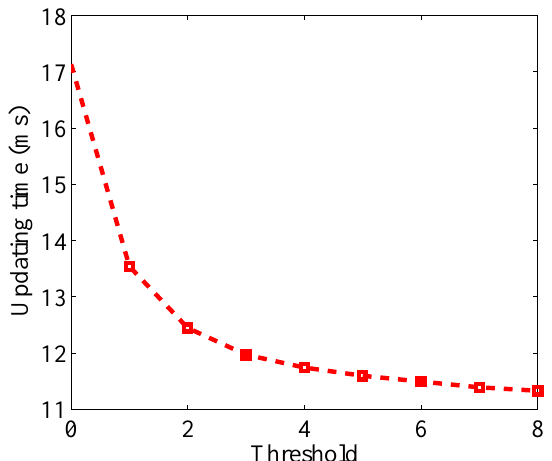
Figure 15. Updating time versus threshold in the binary